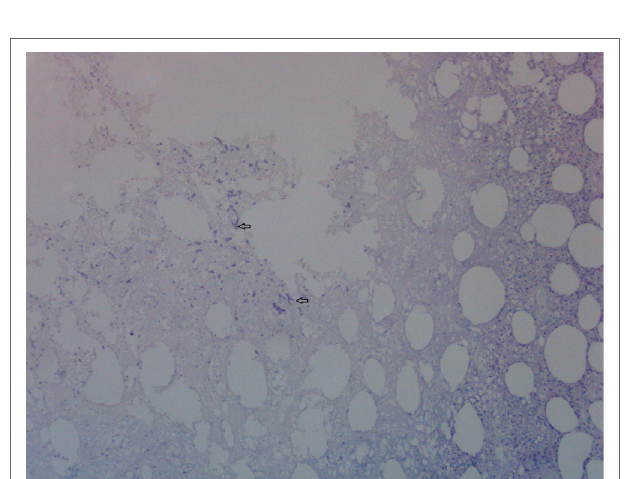
FIGURe 6 | Cerebral biopsy with presence of fungal hyphae. Hematoxylin and eosin stain on cerebral biopsy showing nectrotic tissue with moderate numbers of septate fungal hyphae with parallel walls. Two fungal hyphae with dichotomous branching (diagnostic of Aspergillus ) are depicted